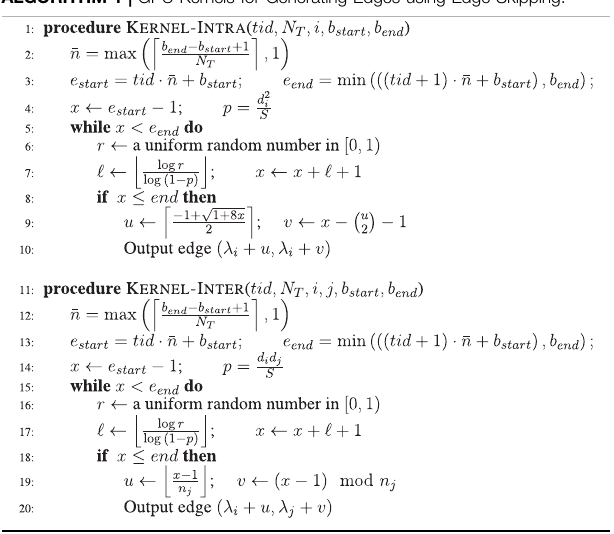
Frontiers in Big Data |